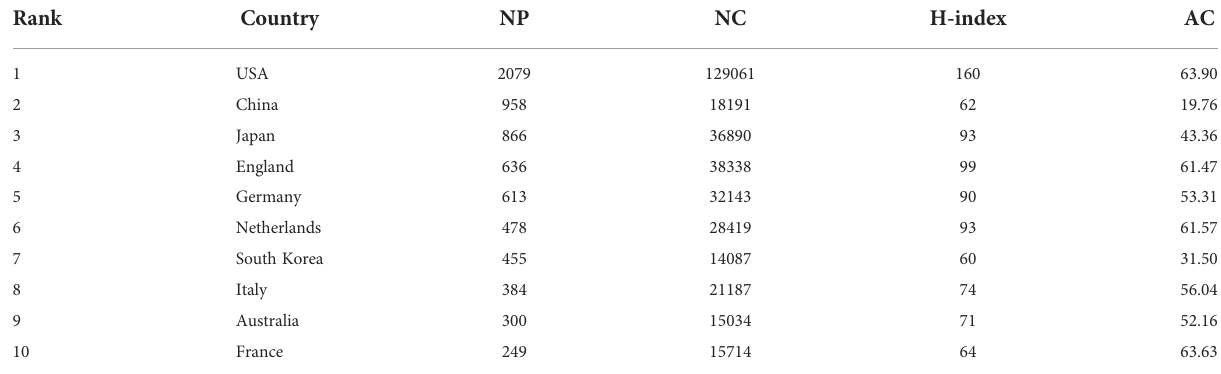
TABLE 1 Top 10 most productive country in macrophages-related RA from 2000 –